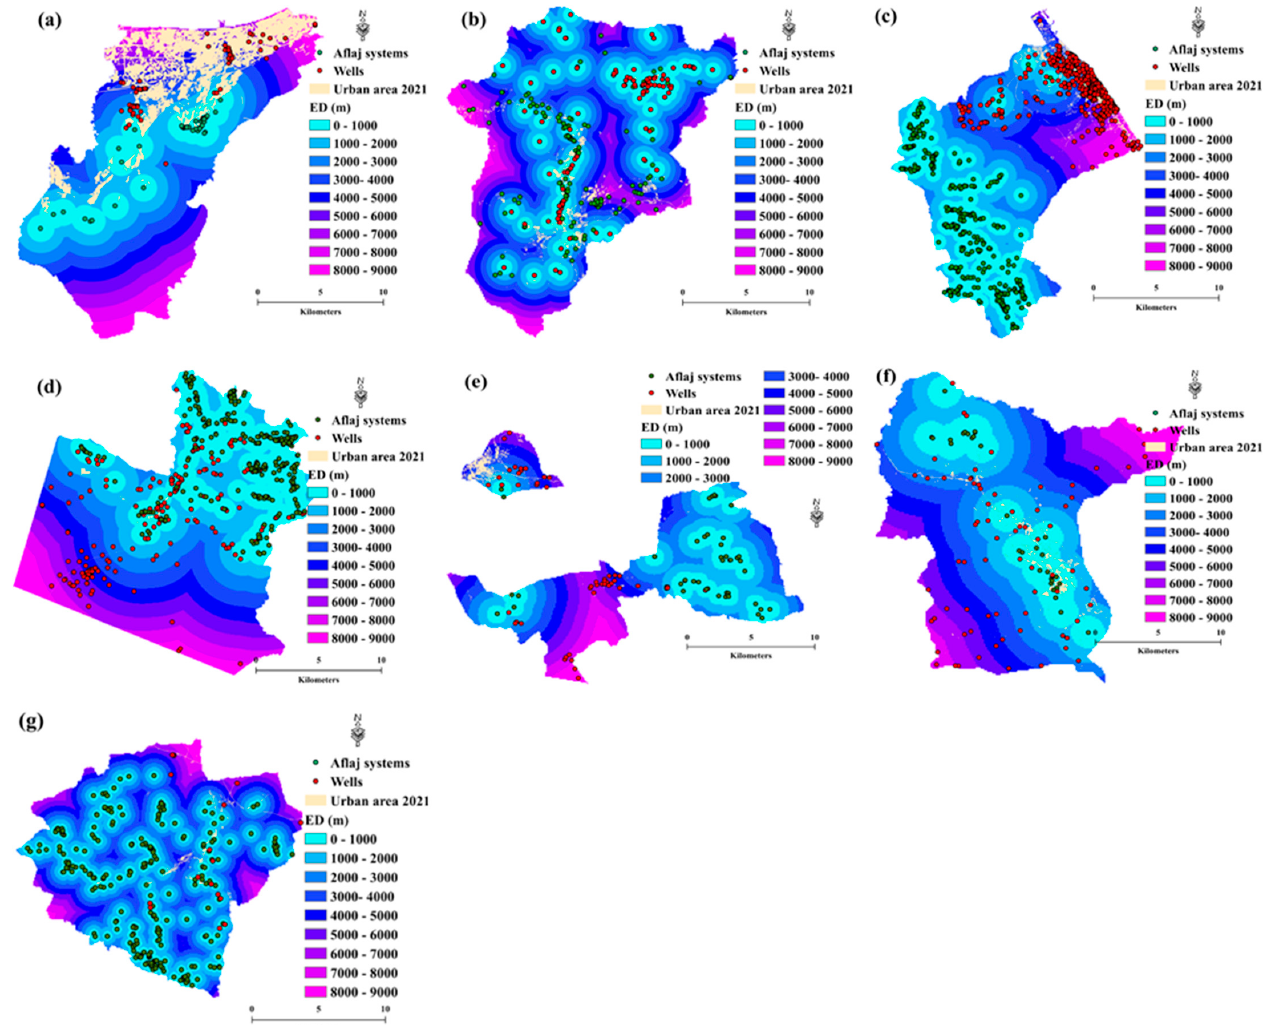
Figure 12. Euclidean distance results overlayed with urban area in 2021 a fl aj systems and well locations in seven cities: ( a ) Bawsher, ( b ) Nizwa, ( c ) Sohar, ( d ) Ibri, ( e ) Al-Buraymi, ( f ) Ibra, and ( g ) Al-Rustaq.